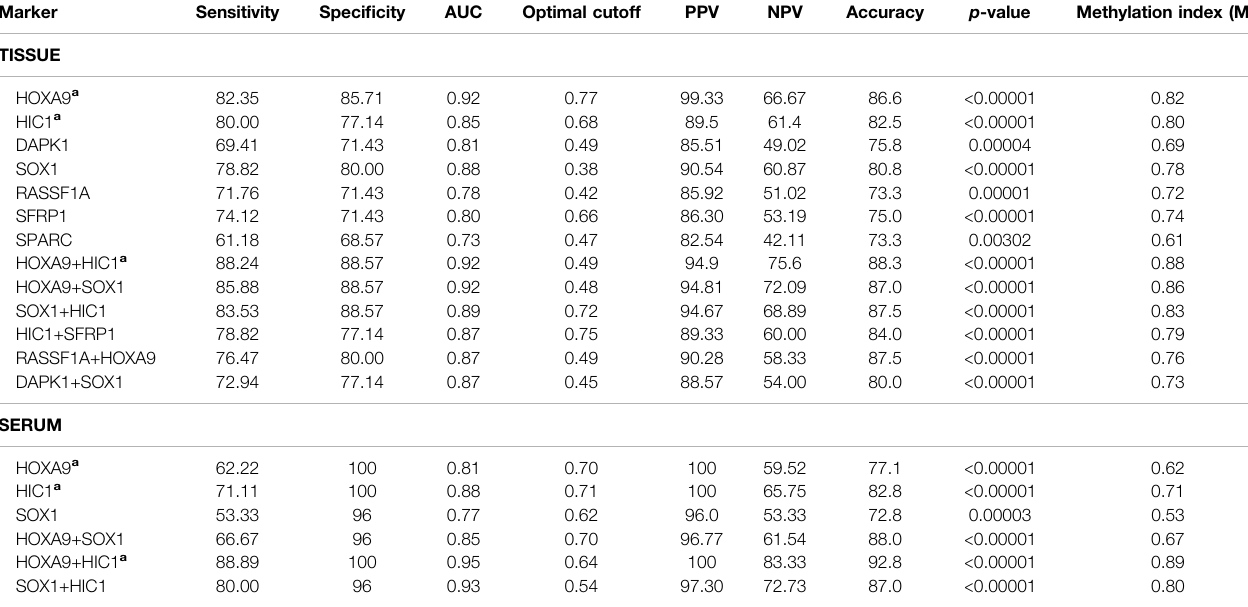
TABLE 2 | Performance assessment of promoter methylation as biomarker for detection of EOC in tissue and serum samples. Table illustrates the Sensitivity, Speci fi city, AUC, Accuracy, Optimal Cutoff and Methylation Index of singleplex and multiplex MethyLight assays for the detection of control and epithelial ovarian cancer patients. AUC: Area under the curve; PPV: Positive predictive value; NPV: Negative prediction value; MI: Methylation Index; p -value: Mann-Whitney U test. Marker Sensitivity Speci fi city AUC Optimal cutoff p